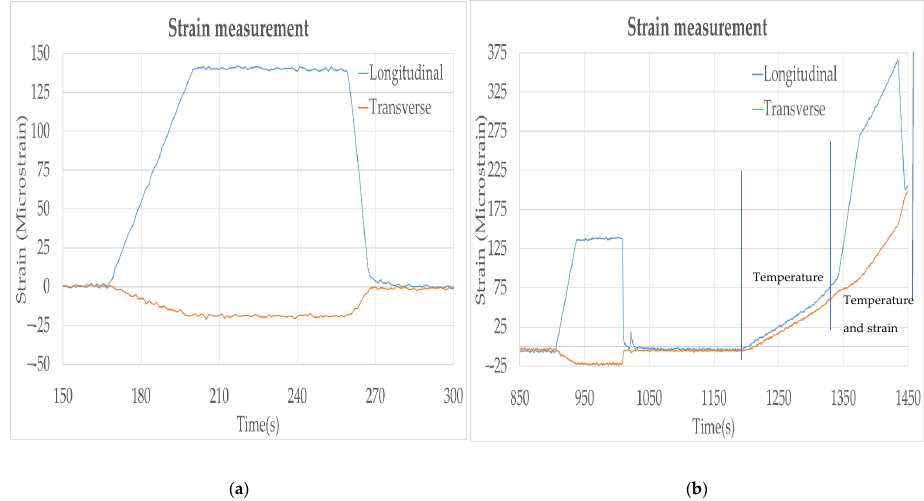
Figure 9. ( a ) Strain measured by longitudinal and transverse FBG sensors. ( b ) Strain measured by both sensors with varying temperature and strain.